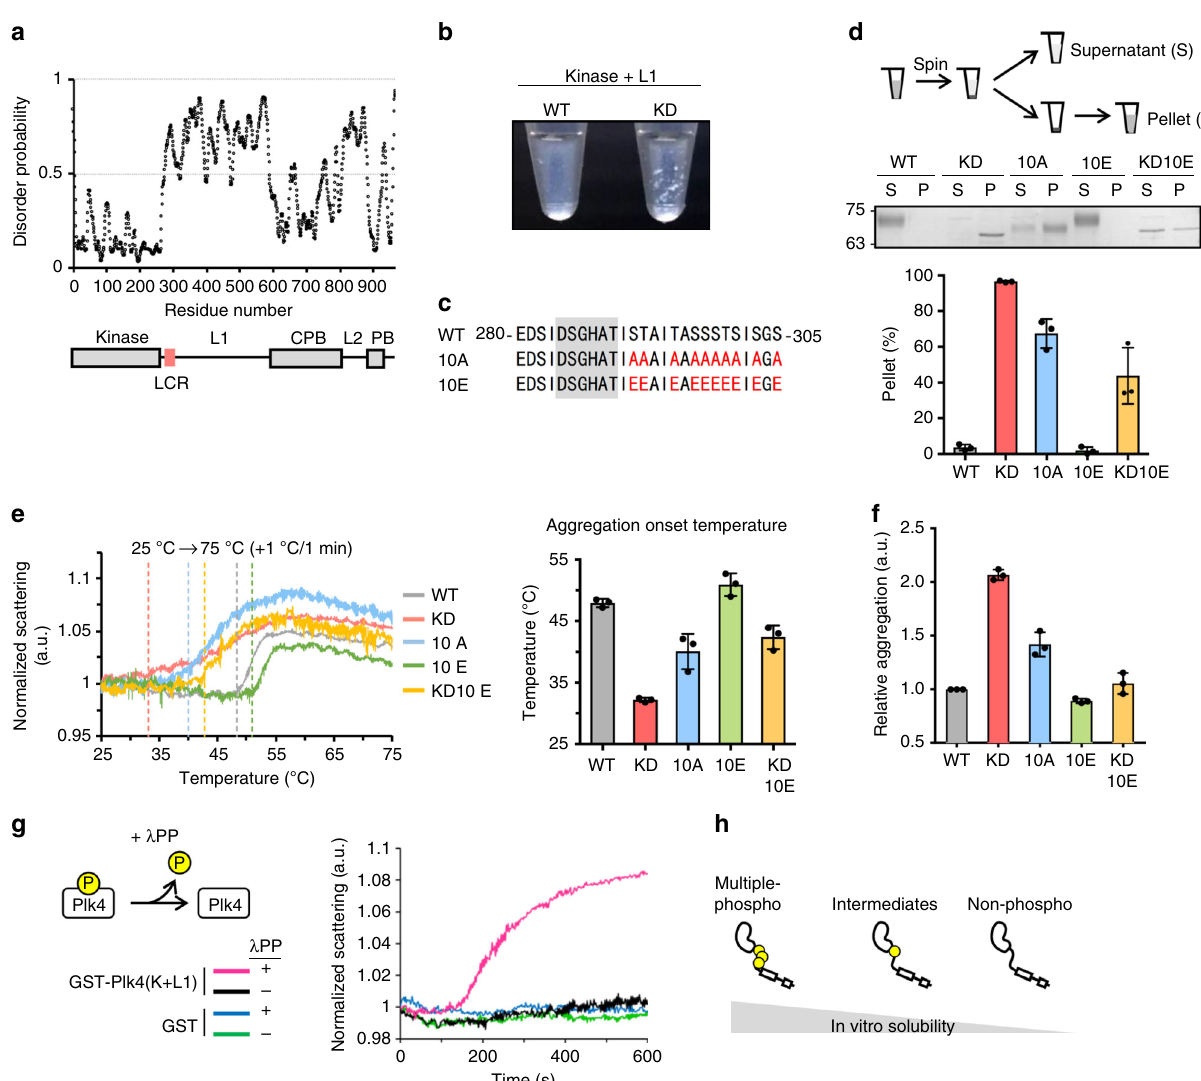
Fig. 1 Plk4 modulates its solubility by autophosphorylation in vitro. a Disorder prediction and schematic of human Plk4 domains. Kinase kinase domain, L1/ L2 Linker 1/2, LCR low complexity region, CPB Cryptic Polo-box, PB Polo-box. b Image of 500 nM Plk4 (Kinase + L1)-His 6 fragments after GST-tag cleavage by PreScission protease. This truncated form was used for in vitro experiments to directly examine the function of L1 in Plk4 condensation. c Amino acid sequence of low complexity region (288 – 303 a.a.) and its neighboring region of human Plk4. Red letters, mutation sites; Gray background, degron motif. d Spin-down assay. After GST-tag cleavage, 500 nM Plk4 (Kinase + L1)-His 6 solution was centrifuged and separated into supernatant (S) and pellet (P) fractions. Representative gel stained with CBB and the quanti fi cation are shown. Graph represents mean percentages ± SD of the pellet fraction from three independent experiments. NaCl, 500 mM. e Measurement of the light scattering of GST-Plk4 (Kinase + L1)-His 6 (100 μ g/ml) under thermal control. Left: Representative data of three independent experiments. Values were normalized to the scattering at 25 °C. Dotted vertical lines indicate each aggregation onset temperature. Right: Aggregation onset temperature. Graph shows mean temperature ± SD from three independent experiments. f Measurement of protein aggregation of 300 nM GST-Plk4 (Kinase + L1)-His 6 by Proteostat aggregation assay. Fluorescence values were normalized to the WT. Graph shows mean ± SD from three independent experiments. g Dephosphorylation assay. GST-His 6 and GST-Plk4(Kinase + L1)- His 6 (100 μ g/ml) were incubated with λ PP at 30 °C for the indicated time and each light scattering was measured. Representative data of three independent experiments. h Schematic of in vitro solubility of Plk4. Source data are provided as a Source Data fi